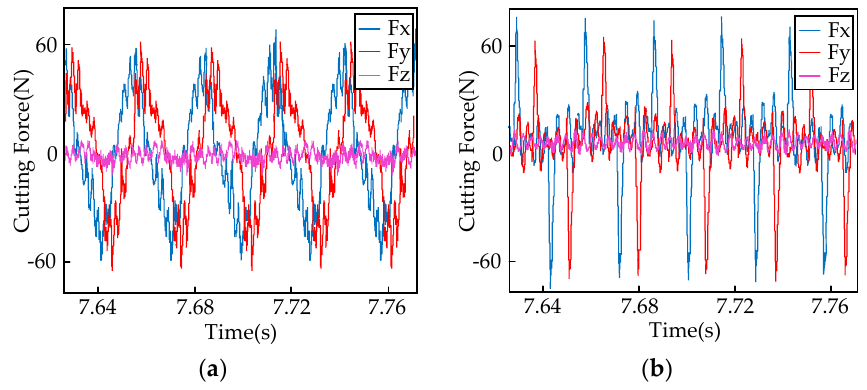
Figure 7. The measurement results of cutting force in milling carbon fiber reinforced plastic (CFRP), ( a ) machining with the rhombic milling cutter and ( b ) machining with the staggered helical milling cutter.